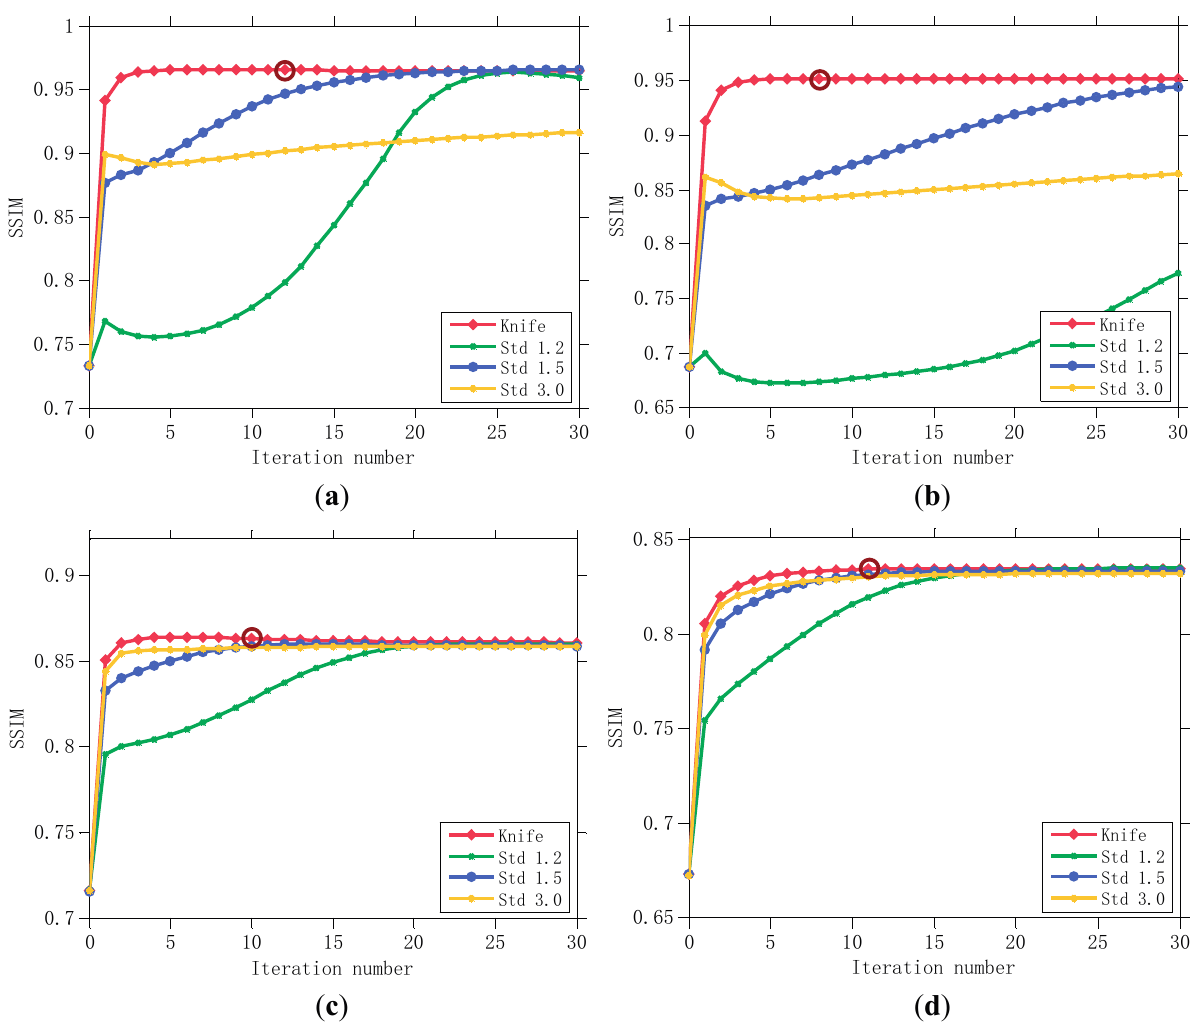
Figure 12. Evolution of SSIM with iterations using different initializations. The AM framework is initialized with the proposed PSF estimation method and with manually selected PSF initializations (a 5 5 × truncated Gaussian PSF with a standard deviation of 1.2, 1.5, and 3.0), represented by “Knife,” “Std 1.2,” “Std 1.5,” and “Std 3.0,” respectively. Stopping positions utilizing the proposed automatic stopping strategy are marked by circles. ( a – d ) correspond to the iterations of Figures 5–8a,